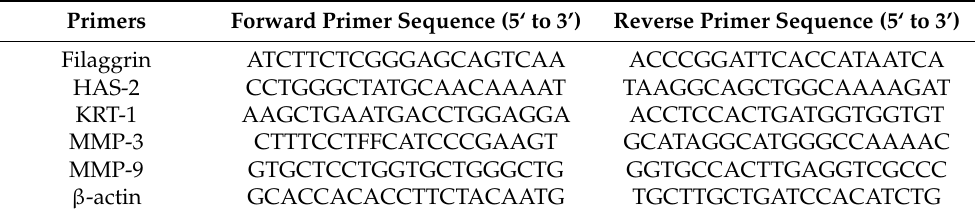
Table 2. Primers used in this